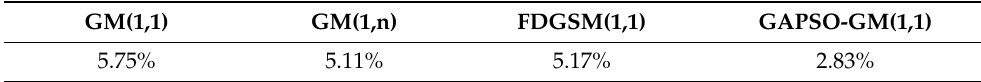
Table 5. MAPE of the training set using the four models.